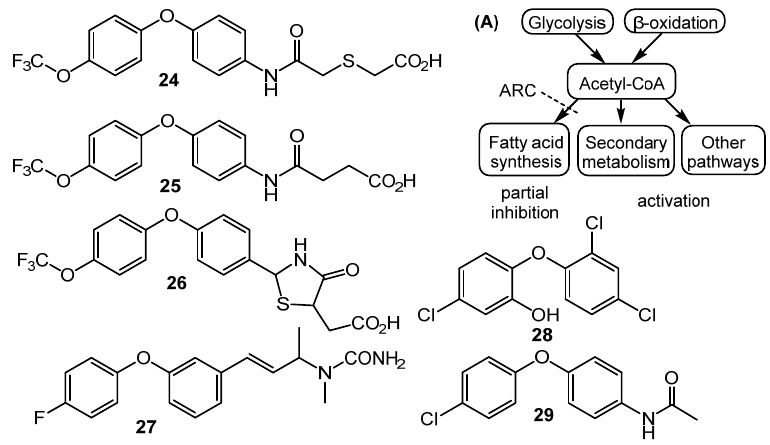
Chart 5. Synthetic diphenyl ethers (ARCs) as elicitors and their mode of action ( A